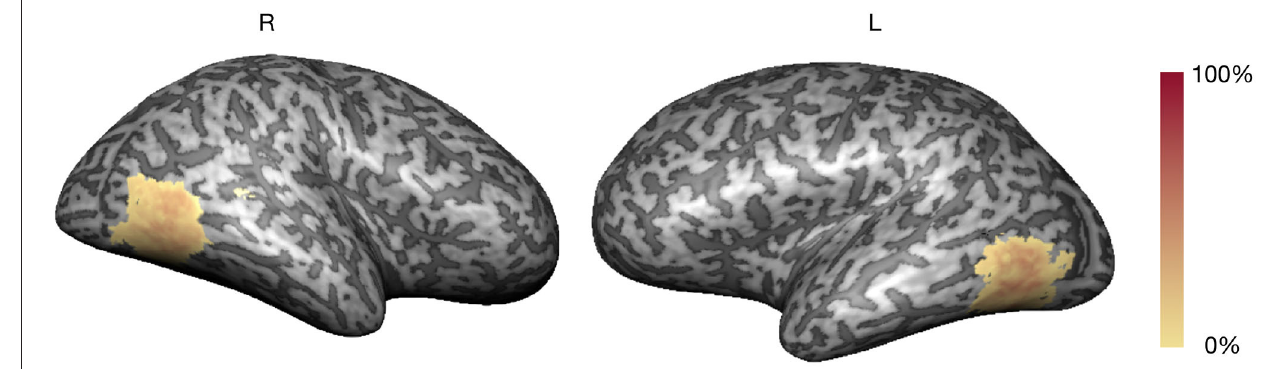
FIGURE 2 | Neurofeedback target probability map (color scale: % overlap).